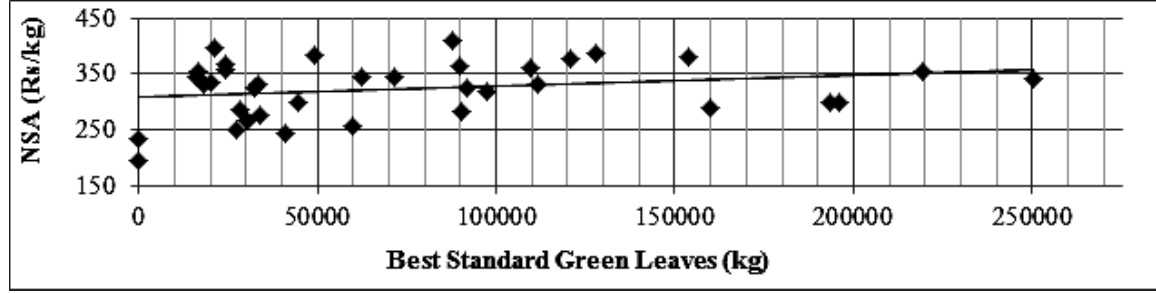
Fig 11: Relationship of Best Leaf Quantity with NSA in Nuwara Eliya Western Sub